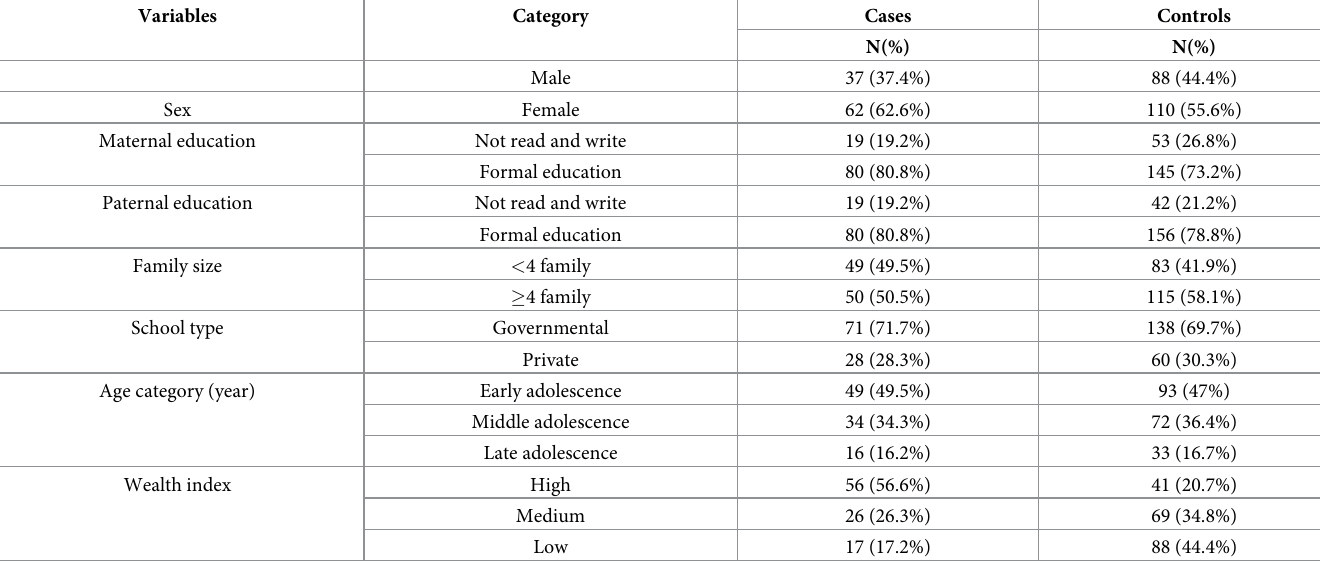
Table 1. Distribution of socio-demographic characteristics of overweight and/or obesity among school adolescents in Butajira Town, Southern Ethiopia, 2019. Variables